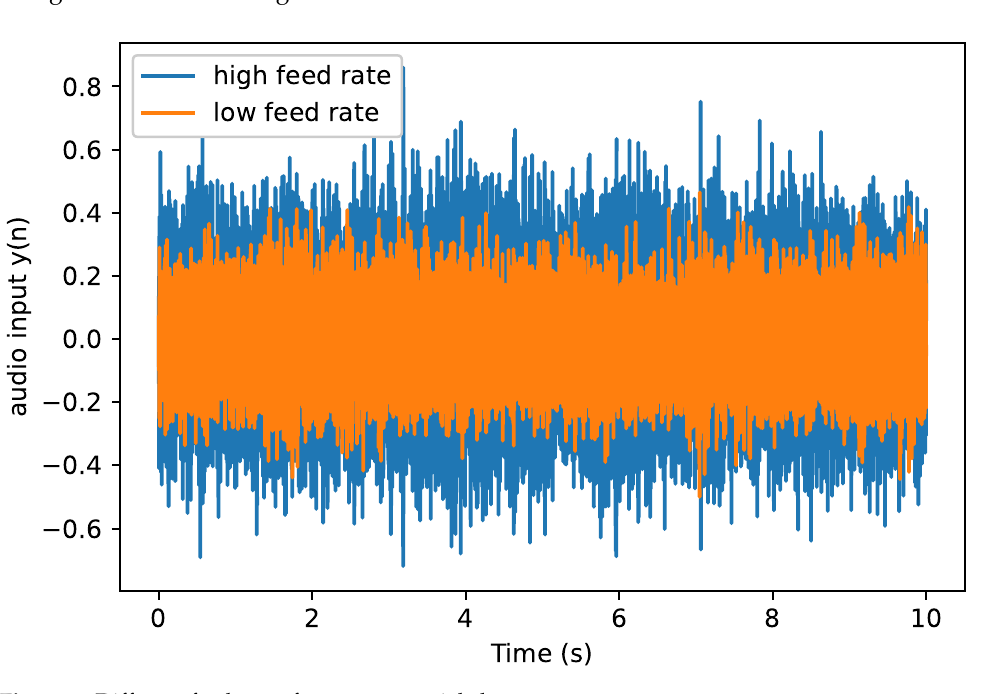
Figure 2. Different feed rates for same material